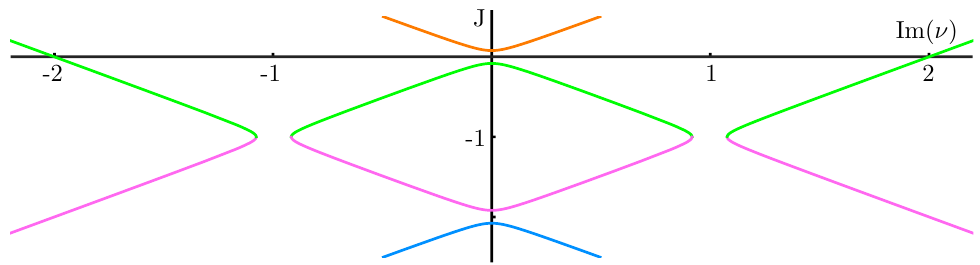
Figure 9 . The Regge trajectories in conformal fishnet theory. At zero coupling the trajectories collide on integer spin and scaling dimension. The four colours correspond to the solutions in (4.1), from top along vertical axis: J 1 is orange, J 2 is green, J 3 is pink and J 4 is blue. Note that Im ( ν ) = − (∆ − 2)